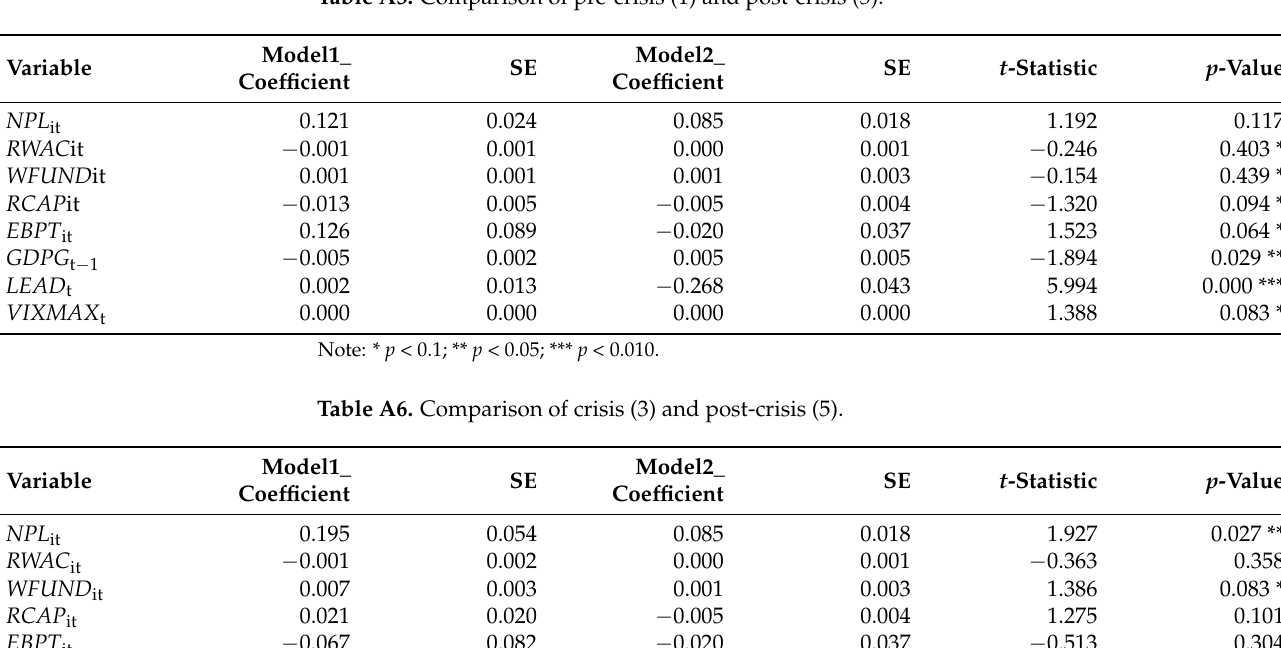
Table A5. Comparison of pre-crisis (1) and post-crisis (5).